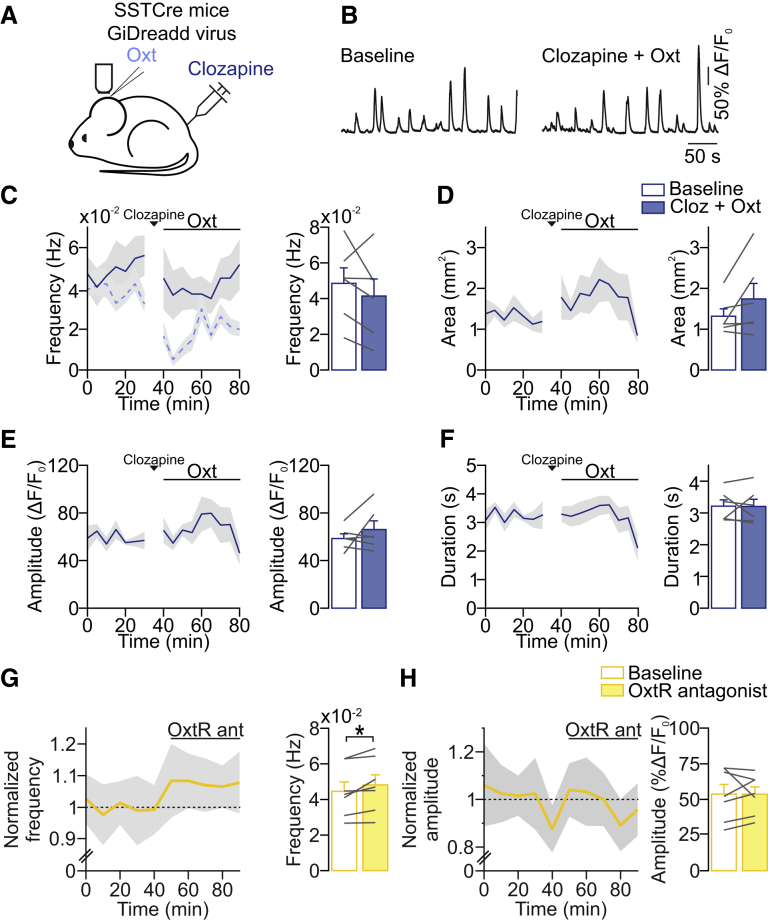
Role for SST+ Interneurons and Endogenous Oxytocin Receptor Activation in Modulating Network Activity In Vivo(A) Schematic representation of the experimental design: wide-field calcium imaging of spontaneous network activity in SST-Cre mice where V1 neurons express GCaMP6s and GiDreadd after viral transduction.(B) Fluorescent changes before and after clozapine + oxytocin application.(C) Network event frequency during baseline and after oxytocin application. Time courses represent 5-min averages. Dashed light blue curve represents data shown in Figure 1D, V1, for comparison.(D) Network event area.(E) Network event amplitude.(F) Network event duration. Data are represented as mean ± SEM.(G) Network event frequency during baseline and after oxytocin receptor antagonist application, in awake animals. ∗p = 0.037 (n = 7 animals; paired two-tailed t test). Data are represented as mean ± SEM.(H) Network event amplitude during baseline and after oxytocin receptor antagonist application, in awake animals.